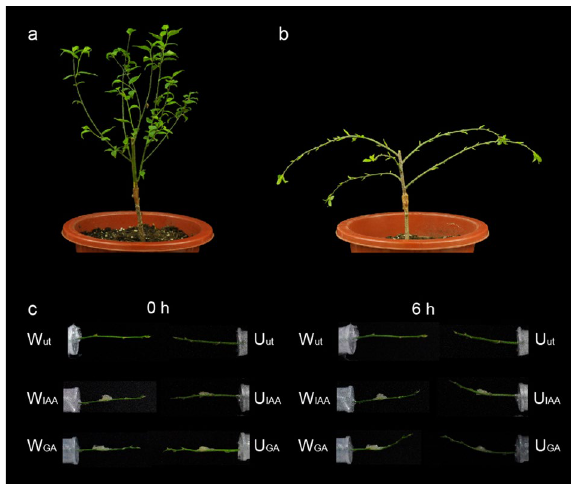
Figure 1. Morphological and hormone responsive characteristics of upright and weeping stems of P. mume . ( a ) Morphological characteristics of grafting progenies of F 1 population with the upright trait; ( b ) Morphological characteristics of grafting progenies of F 1 population with the weeping trait; ( c ) Changes in angles of upright and weeping stems in different treatments; U ut , upright stem; W ut , weeping stem; U IAA , upright stem with IAA treatment; W IAA , weeping stem with IAA treatment; U GA , upright stem with GA 3 treatment; W GA , weeping stem with GA 3